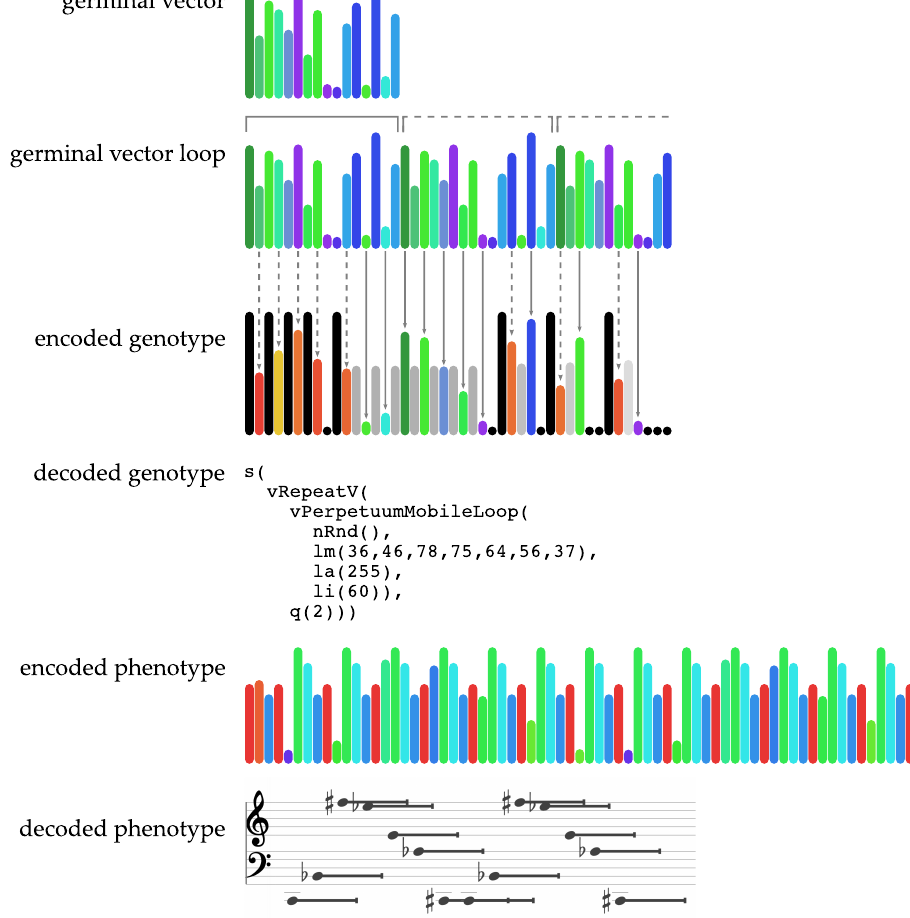
Figure 10. Germinal vector used as a circular array to originate a longer encoded genotype vector. Solid lines relate to numbers transposed without alterations (the color does not change). These values correspond to the leaves of the functional tree expression. Dashed lines denote changes in the original value: they are function indices encoded as golden values (red-orange colors), pointing to the chosen functions to build the decoded genotype. Note that the lengths of such related values are similar since the algorithm explained in Figure 5 makes this choice by looking for the closest available function index of the required type.